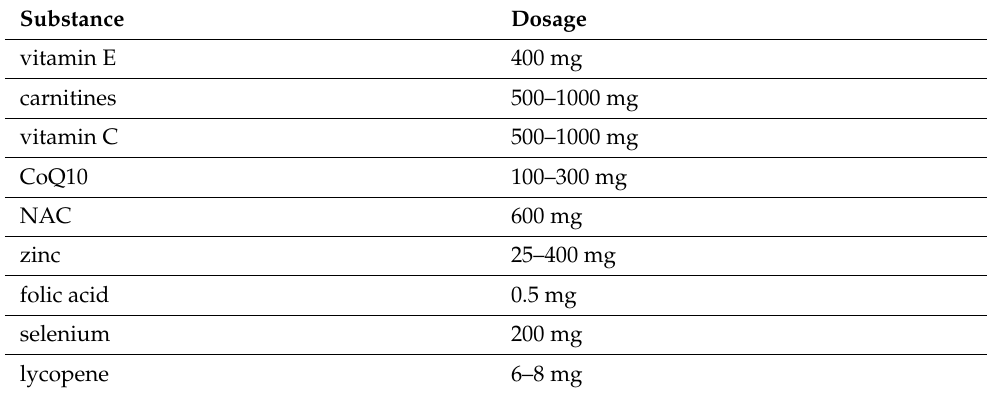
Table 3. Preparations with potential positive effect on male